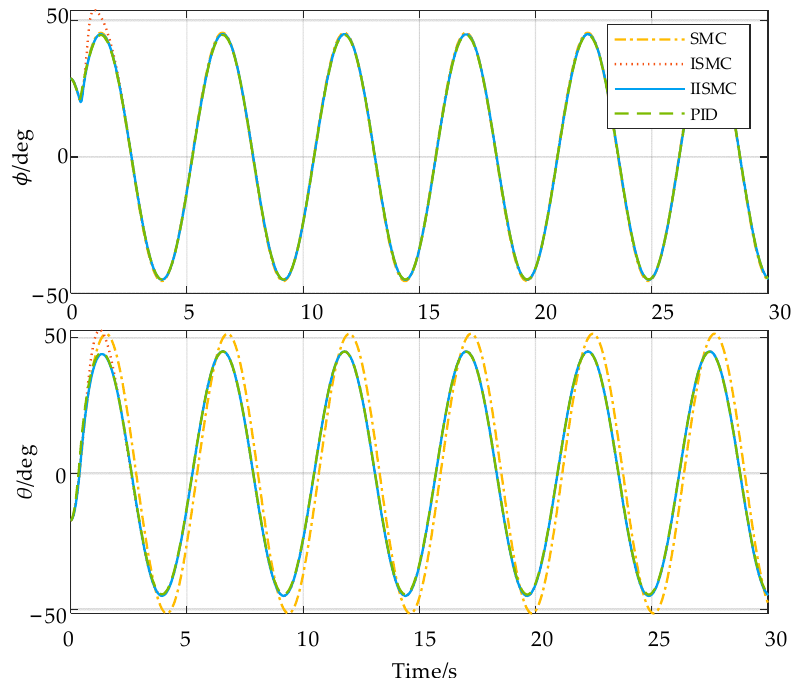
Figure 16. Attitude angles under four control methods in Scene 4.